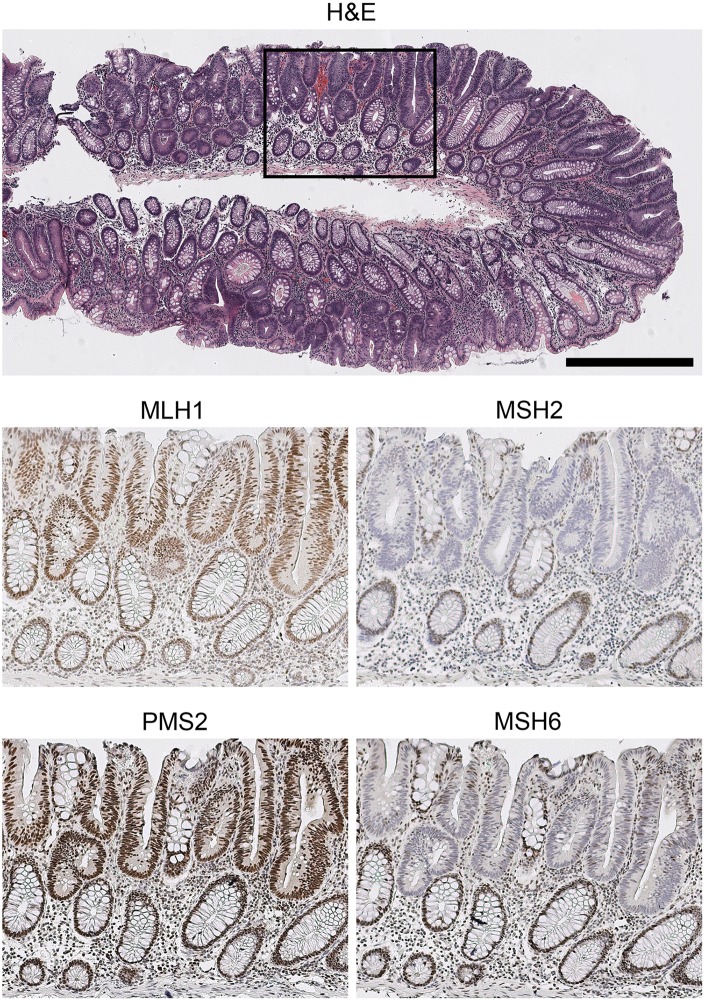
High concordance between IHC and MSI results using LMRs.There was 96% (79/82) concordance between MSI results using LMR repeats and loss of MMR expression by IHC. For example, tubular adenoma 267B was unstable at all five markers and lacked MSH2 and MSH6 expression. Note that when MSH2 is lost, the level of binding partner MSH6 is often significantly lower due to reduced stability. The area indicated by the rectangle in the H&E panel is enlarged 2x in each of the lower panels. Size bar for H&E, 500μm.